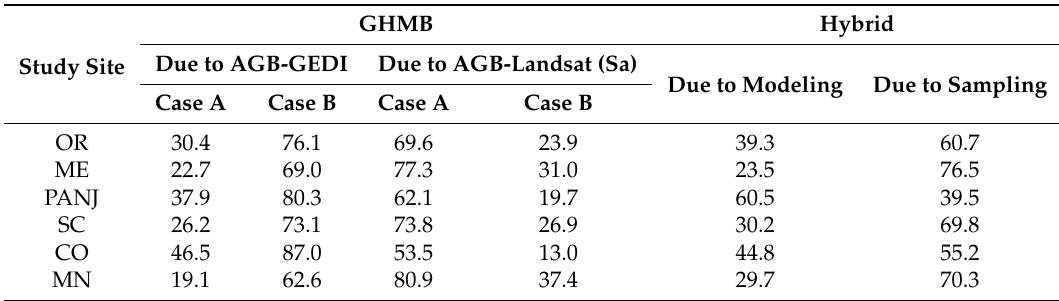
Table 9. Proportion (percentage) of the variance due to different sources for the GHMB and hybrid estimation methods,